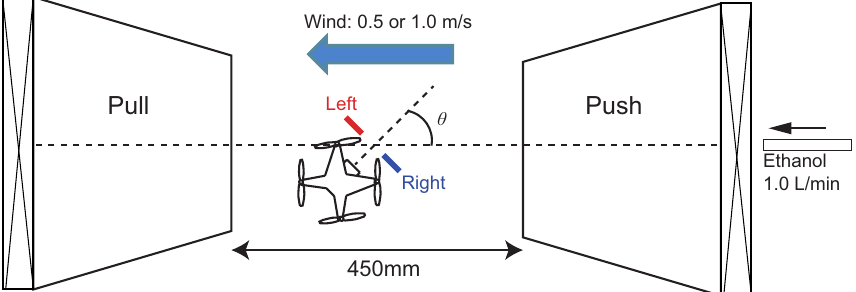
Figure 10. Experiment setup for investigating the odorant detection directivity using the push-pull ventilation system.